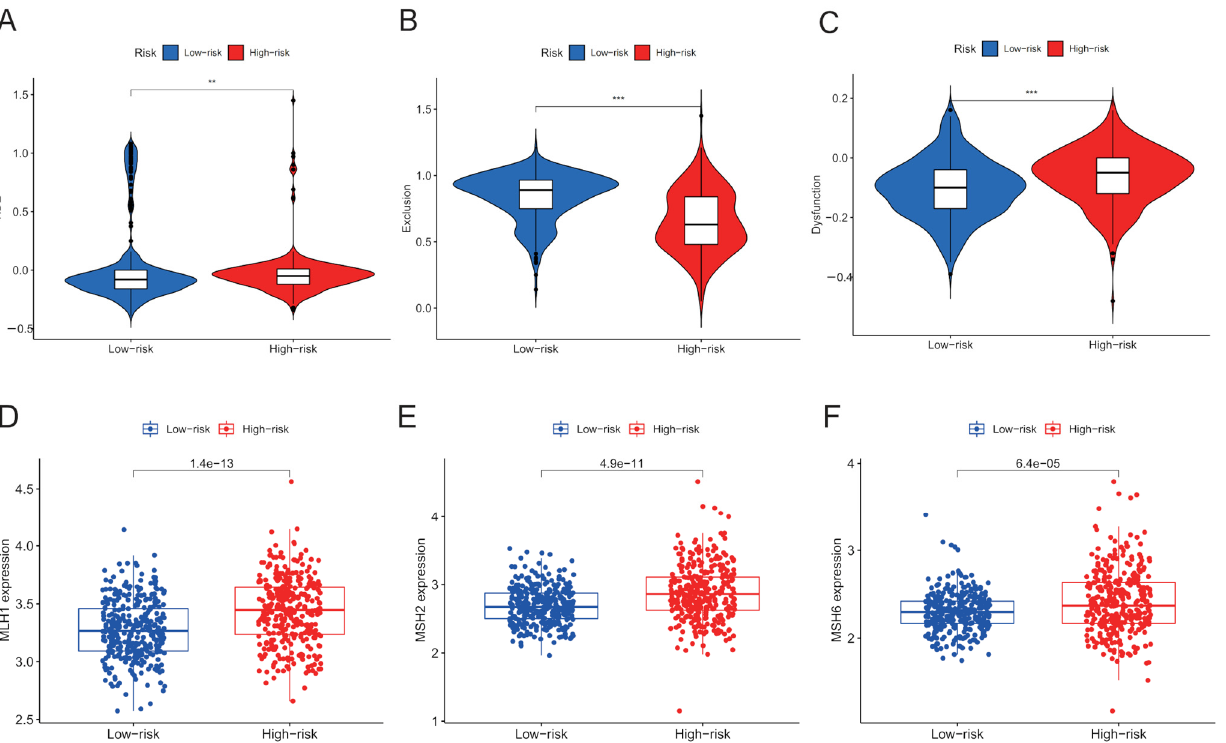
Figure 6. Potential responses to ICB therapy of different IGRPS subgroups. ( A – C ) TIDE, T cell exclusion and dysfunction score in different subgroups. Wilcoxon test compared scores between the two groups. ( D – F ) Box plots visualizing significantly differentially expressed MMR genes (MLH1, MSH2, and MSH6) in the two groups.** p < 0.01, *** p <